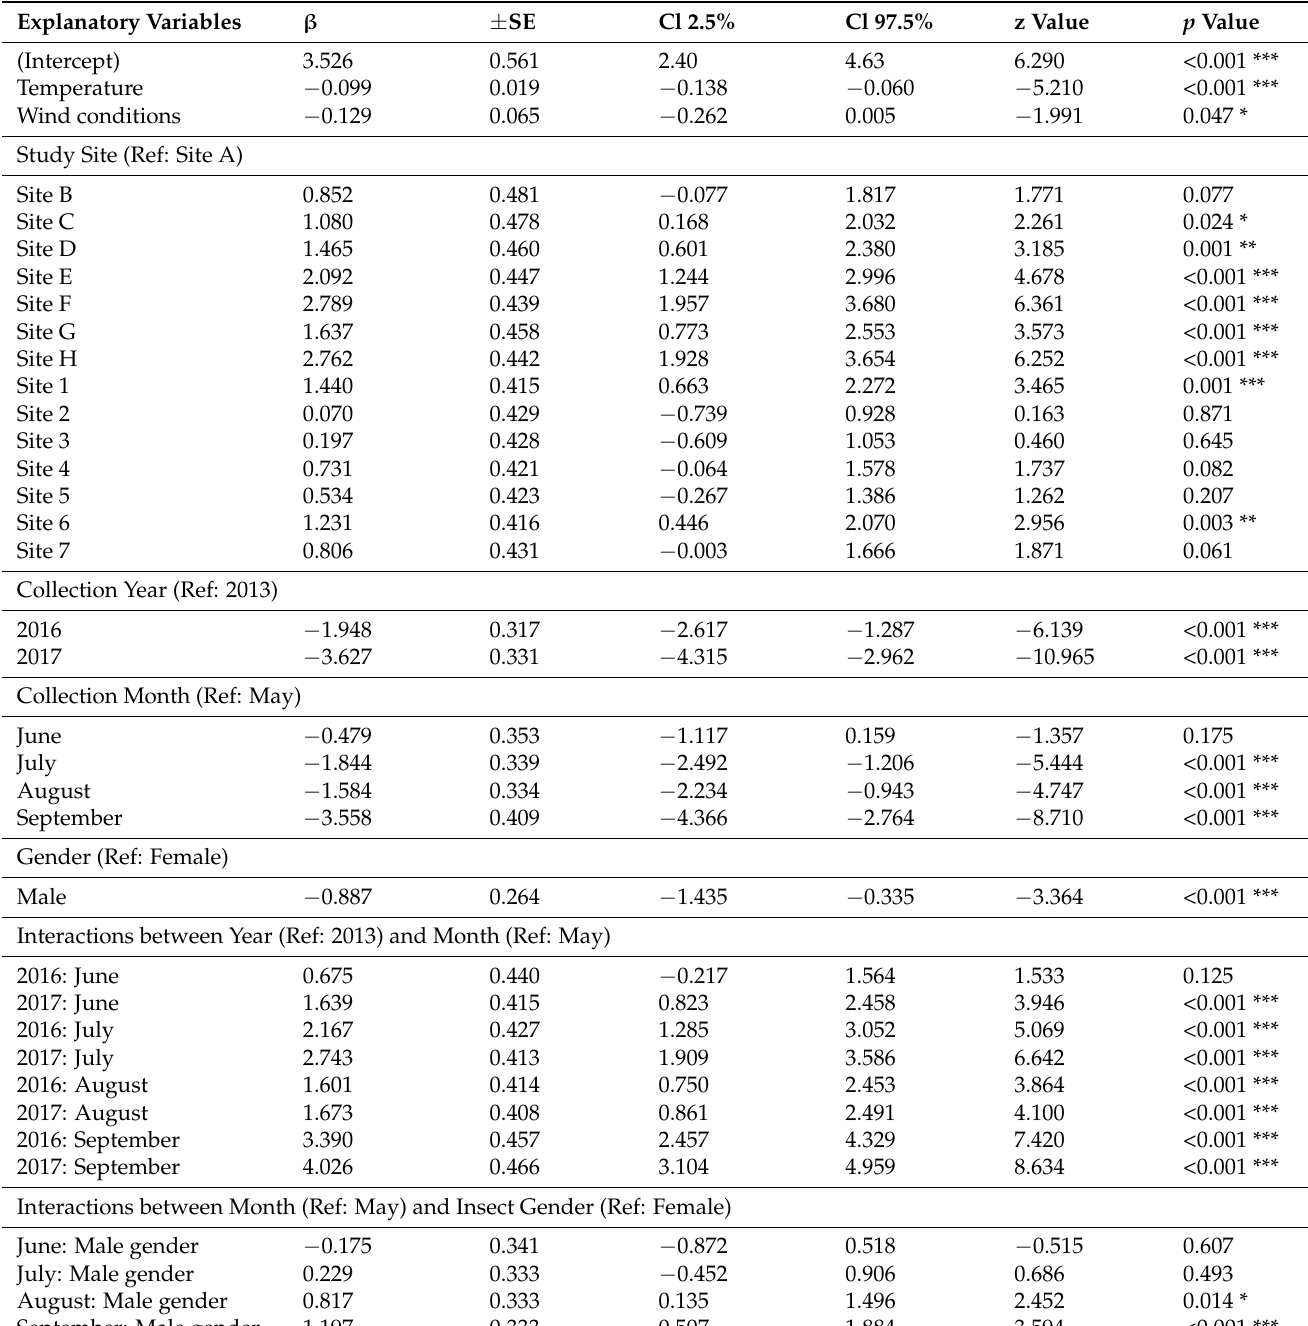
Table 1. Generalized linear model (GLM) results showing how independent variables influence the number of collected